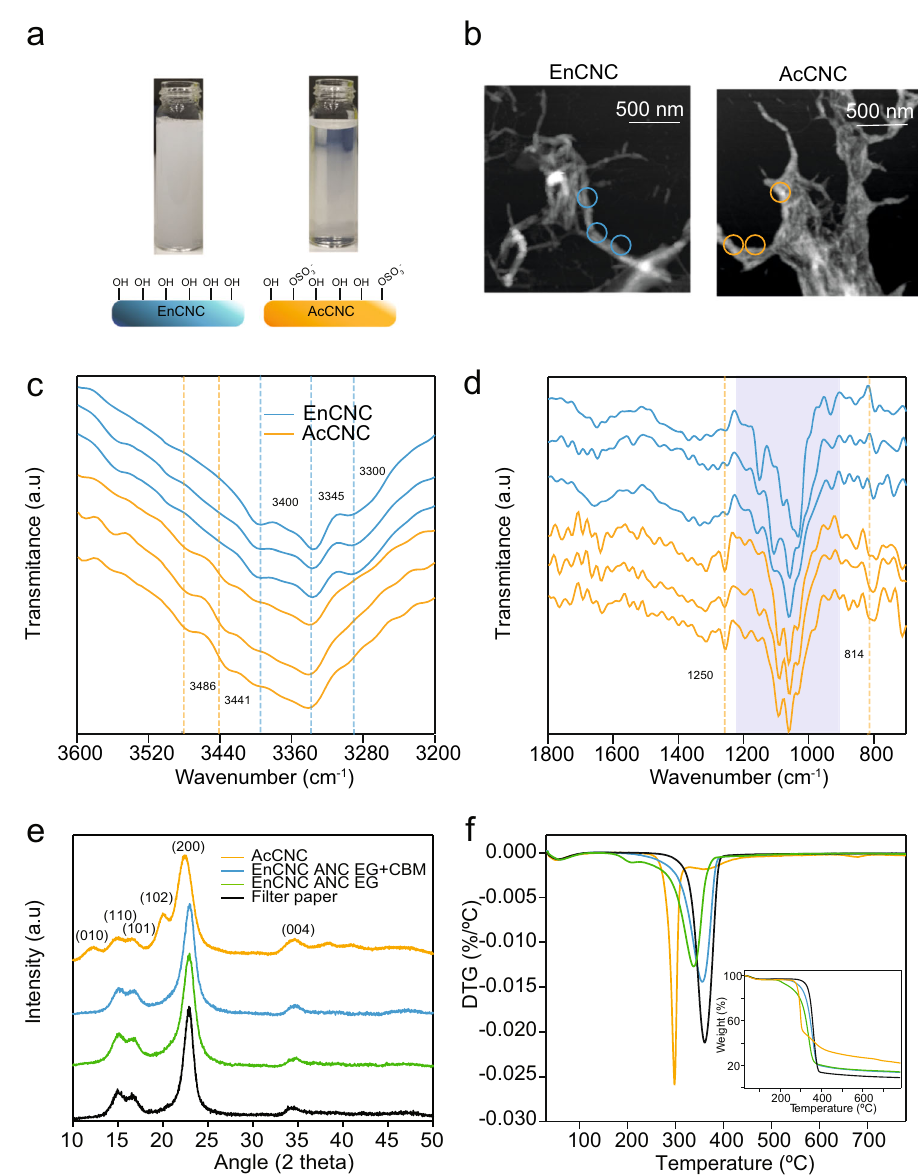
Fig. 3 Nanocellulose physicochemical characterization. a Aqueous suspension of EnCNCs and AcCNCs. Illustration of free – OH groups in EnCNC surface and the random – OSO 3 − groups anchored by the sulfuric acid treatment in the AcCNC surface. b Topography images from EnCNC and AcCNC samples used for nano-FTIR measurement. Color circles mark the analyzed nanocrystals. c , d Spectra from EnCNC and AcCNC nanocrystals selected in two different regions, 3600 to 3200 cm − 1 and 1800 to 750 cm − 1 . Spectra form EnCNC and AcCNC showed different peaks due to its different polymorph structure and AcCNC sulfate content. e X-ray diffraction analysis of the fi lter paper, EnCNCs produced by 24 h hydrolysis of ANC EG and ANC EG + CBM and AcCNCs. Figure shows the diffractograms of cellulose I in the fi lter paper and EnCNCs. The different planes are indicated. f Thermogravimetric analysis curves of fi lter paper, EnCNCs produced by 24 h hydrolysis of ANC EG and ANC EG + CBM and AcCNCs. Weight loss curves and derivative from TGA We further analyzed single EnCNC particles using nano-FTIR, which allows infrared analysis with nanoscale resolution (Fig. 3b) 29 . The color circles in the topography images in Fig. 3 mark the crystals selected for the measurement, and the corresponding nano- FTIR spectra are shown in Fig. 3c, d. We observe that only the nano-FTIR spectra of AcCNC fi bers show the shoulders at around 3486 and 3441 cm − 1 (marked with orange lines) that con fi rm the cellulose II structure. The peak at 814 cm − 1 (marked with orange lines) indicates the sulfur present in individual crystals. Nano-FTIR offers improved sensitivity compared to FTIR, showing intensi fi ed O – H peaks at 3300, 3345, and 3400 cm − 1 (marked with blue lines).